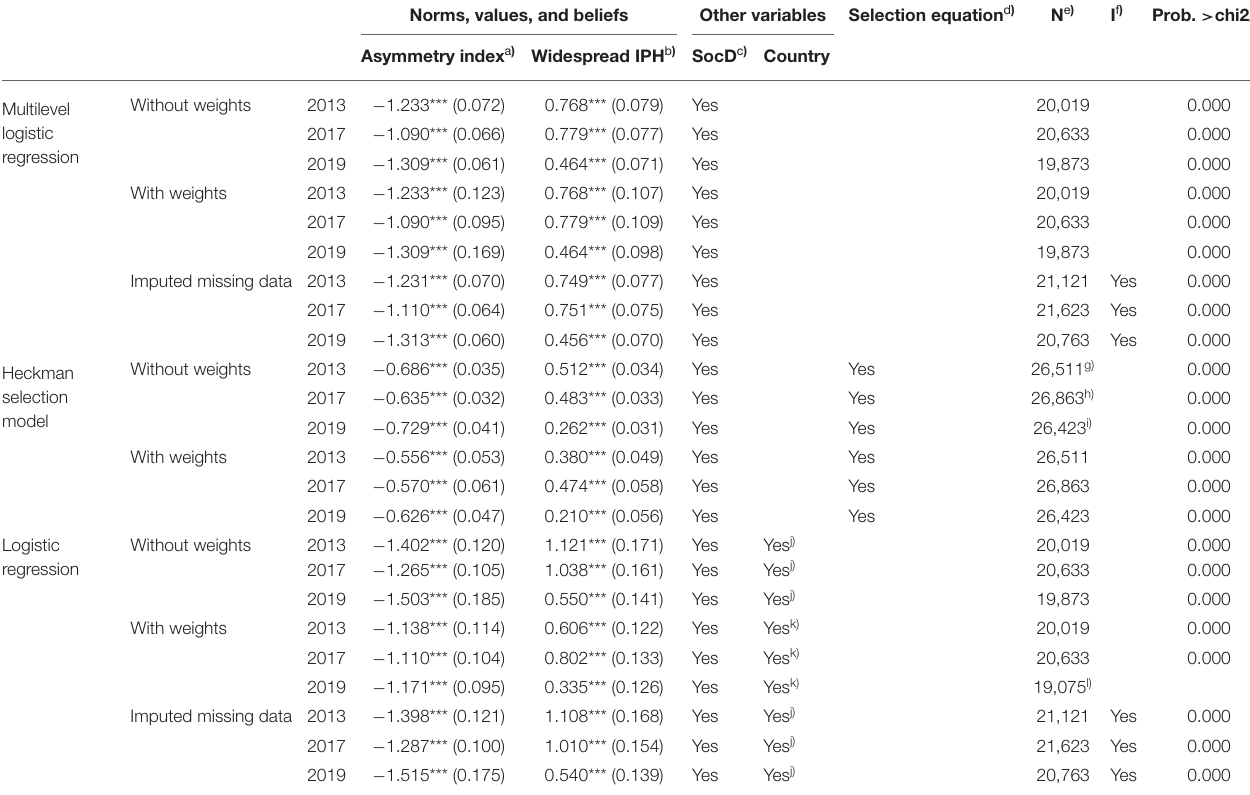
TABLE 3 | Robustness analysis.